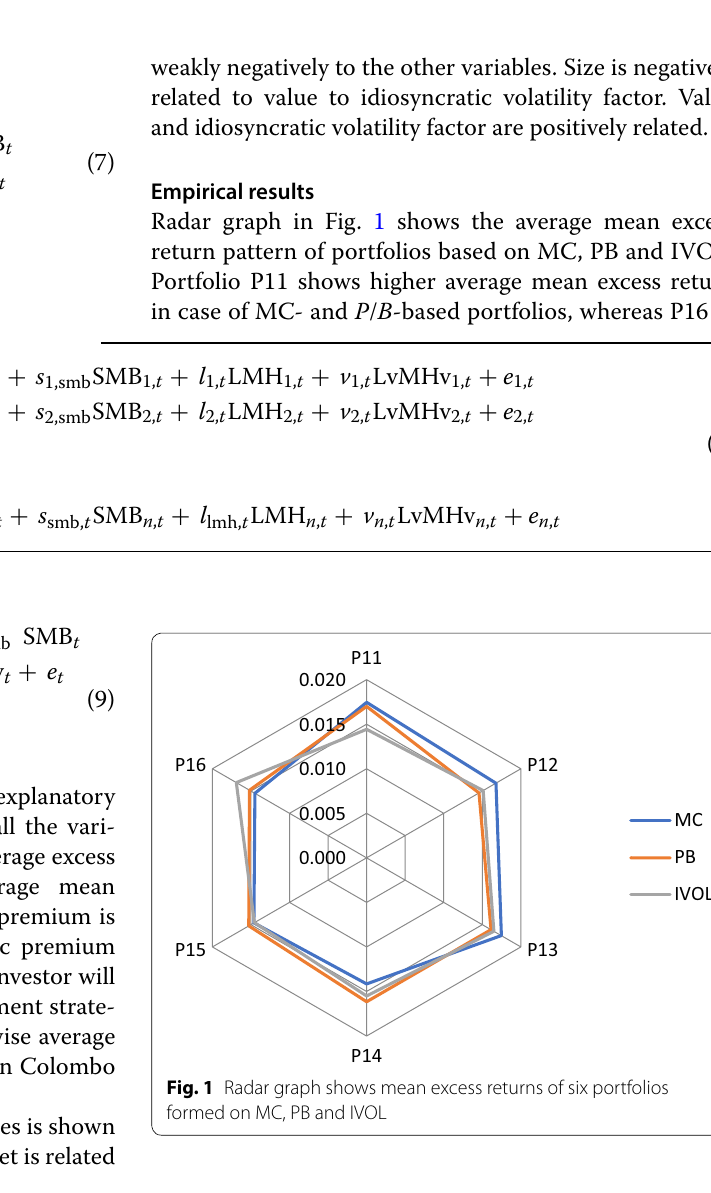
Table 2 Year-wise monthly IVOL Average monthly IVOL